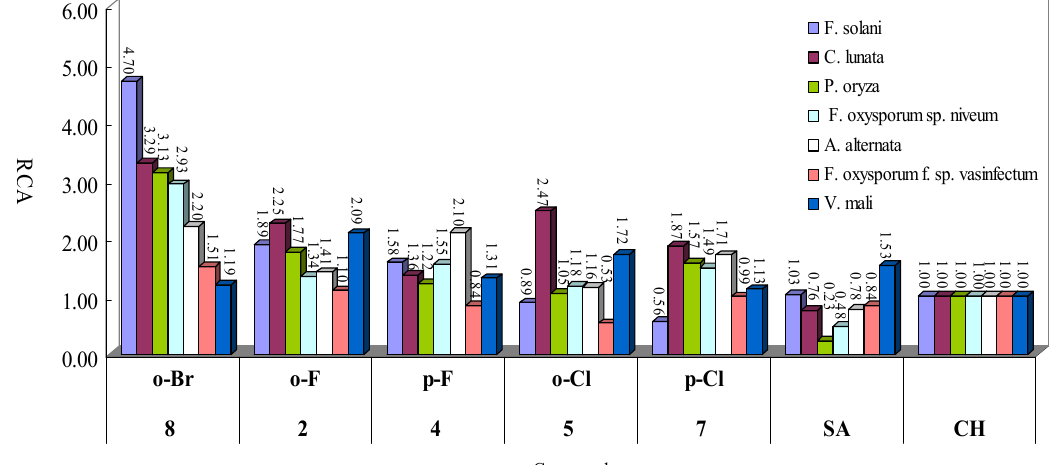
Figure 3. Relative comprehensive activities of the compounds against seven